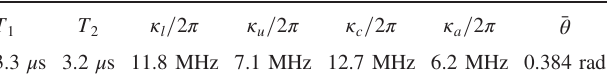
TABLE III. Coherence times and decay rates at zero flux Φ ¼ 0 and T ¼ 20 mK.